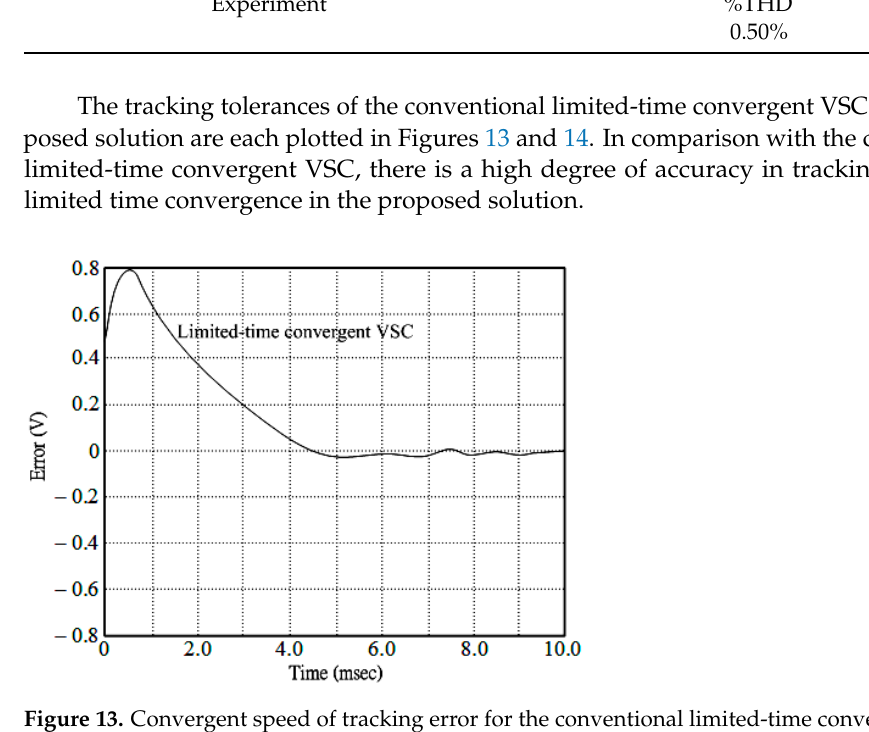
Figure 13. Convergent speed of tracking error for the conventional limited-time convergent VSC.